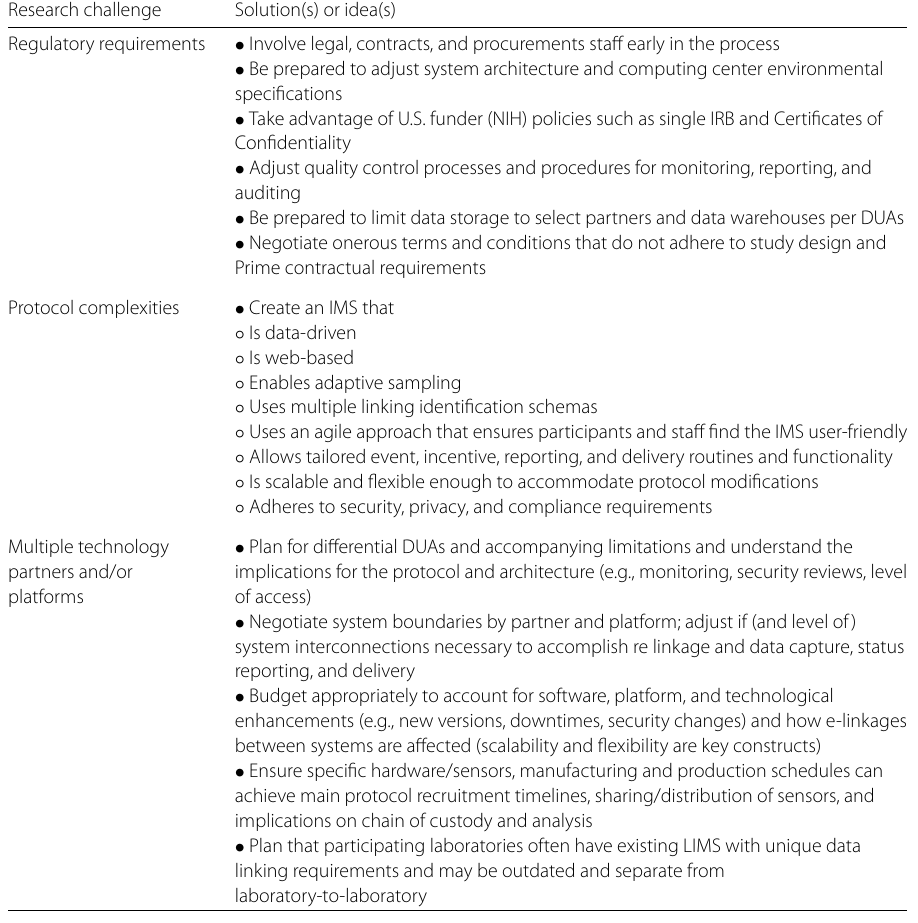
Table 6 Lesson learned when connecting, enriching, and linking “big data” with survey data Research